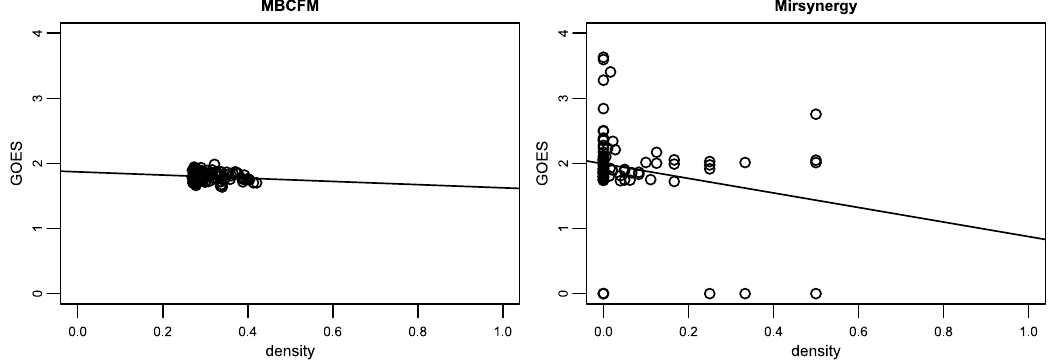
Figure 5. The functional consistency analysis of OV CMFMs. Though lots of modules detected by Mirsynergy have some GO-BP terms, their density values are zero. It shows that these mRNAs are loosely clustered into some modules, and not able to form an effective biological relationship with